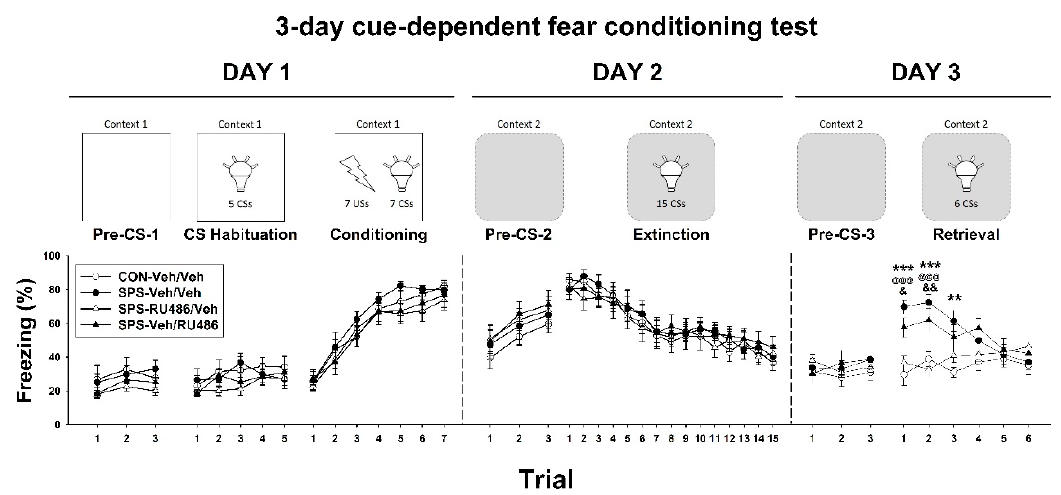
Figure 1. Three-day cue-dependent fear-conditioning test after SPS paradigm and early/late RU486 intervention. The data represent the mean ± SEM. n = 12 for each group. Statistical analysis was employed with a two-way repeated measures ANOVA followed by Bonferroni post hoc testing.